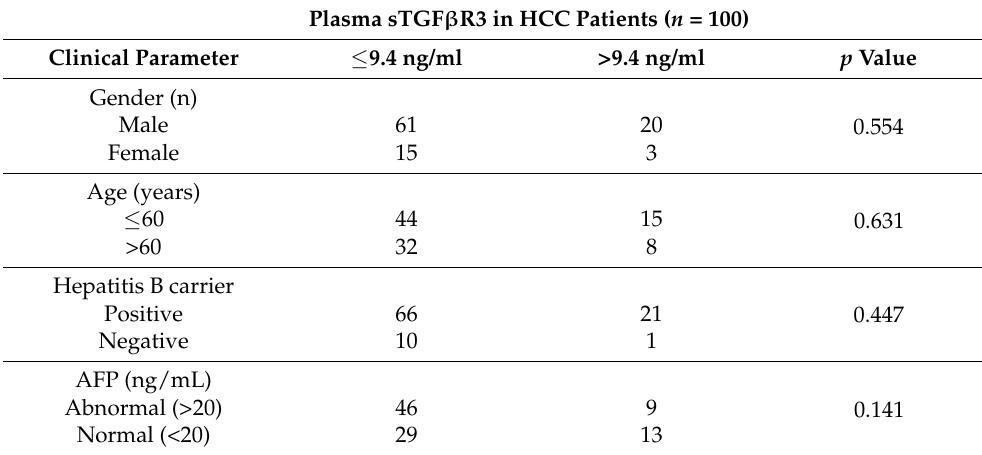
Table 2. Correlation between plasma sTGF β R3 and clinicopathologic